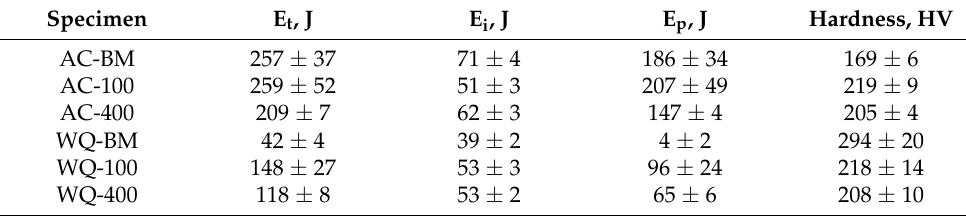
Figure 4. Stress–strain curves for the specimens with air-cooled base metal (AC-BM) and water-quenched base metal (WQ-BM). Table 2. Charpy impact energies and hardness for base metal and CGHAZ at − 20 ◦